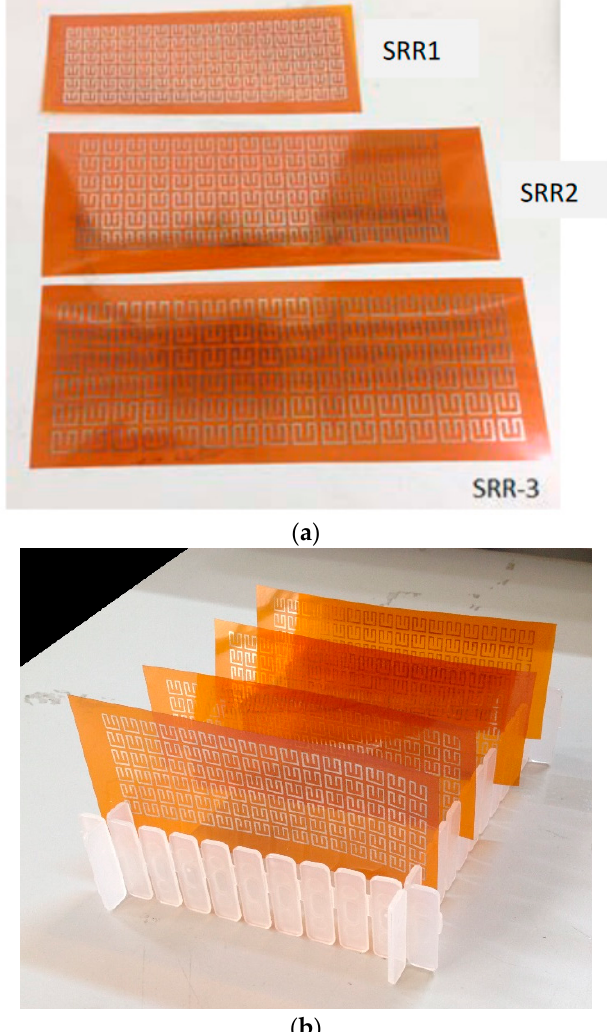
Figure 5. Photographs of printed split-ring resonators. ( a ) SRR1, SRR2, and SRR3, ( b ) More printed products.